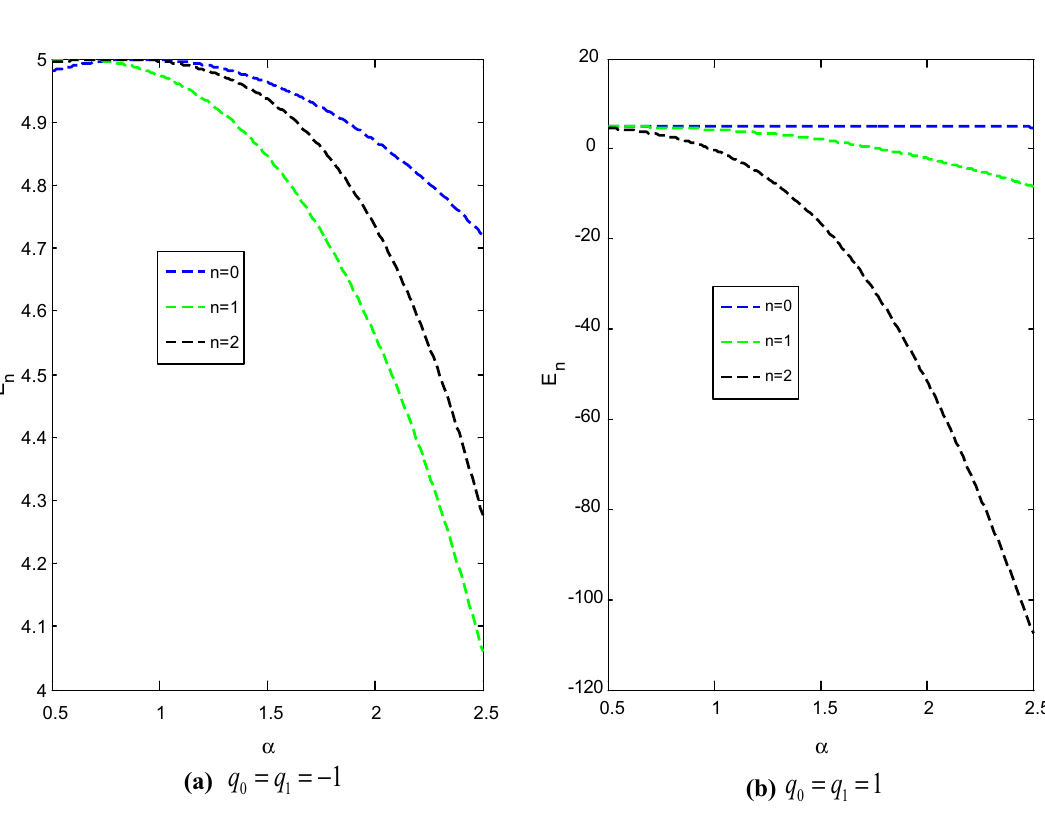
Figure 1. Variation of energy E n against the screening parameter α , with (cid:31) = µ = 1, r e = 0.4 and D e = 5